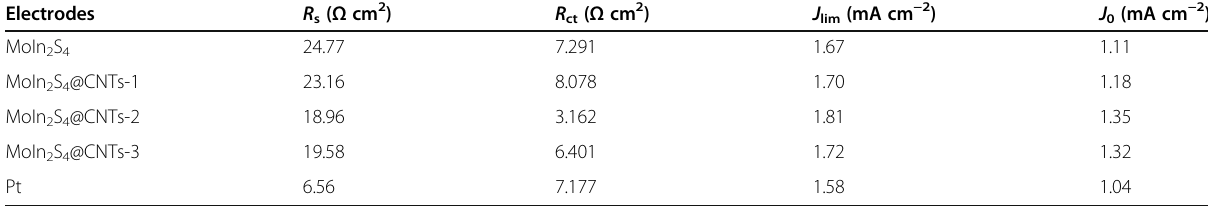
Table 2 Electrochemical parameters for the different CEs